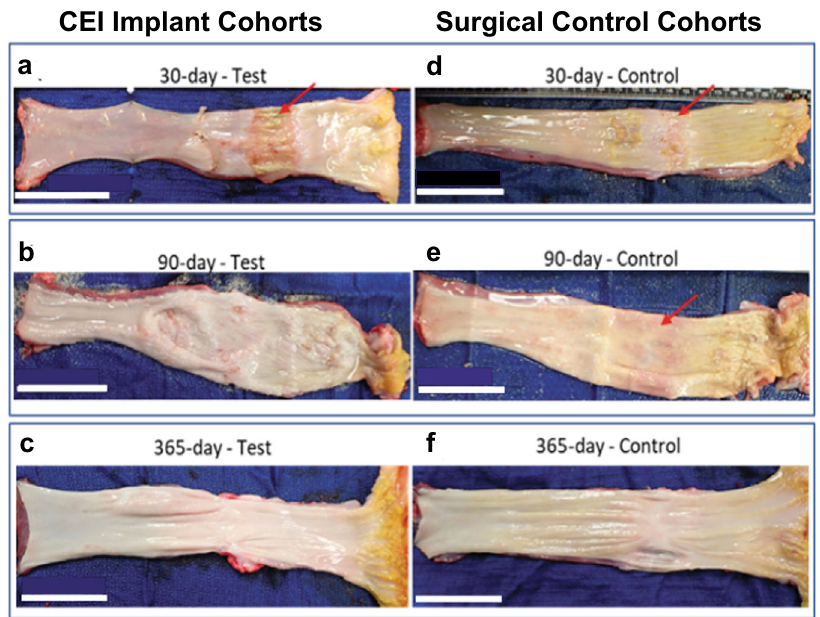
Fig. 5 Gross histology of esophageal tissue from 30-, 90- and 365-Day cohorts. Representative gross images of explanted esophagus containing treatment site at necropsy. Esophagus from test animals (treated with the CEI) and control animals survived to various times: 30-day survival ( a , d ; arrows indicate area that is not epithelialized); 90-day survival ( b , e ; arrow indicates area that is not epithelialized); 365-day survival ( c , f ). White scale bars = 5